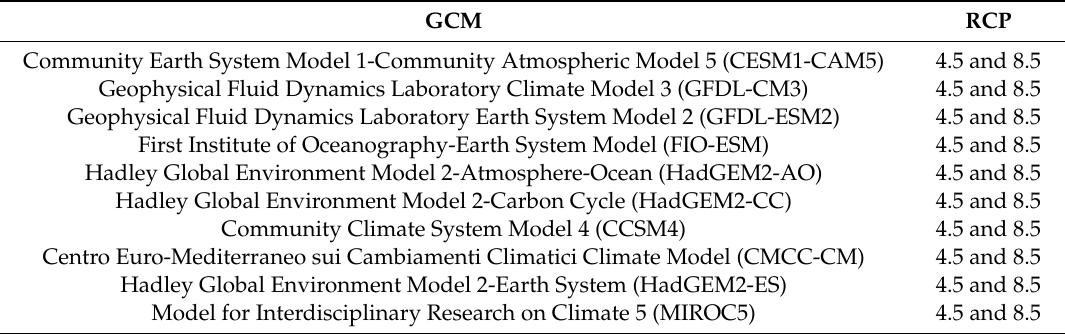
Table 1. Coupled Model Intercomparison Project (CMIP5) global climate model (GCM) and Representative Concentration Pathway (RCP) combinations used for Soil and Water Assessment Tool (SWAT) climate change scenario